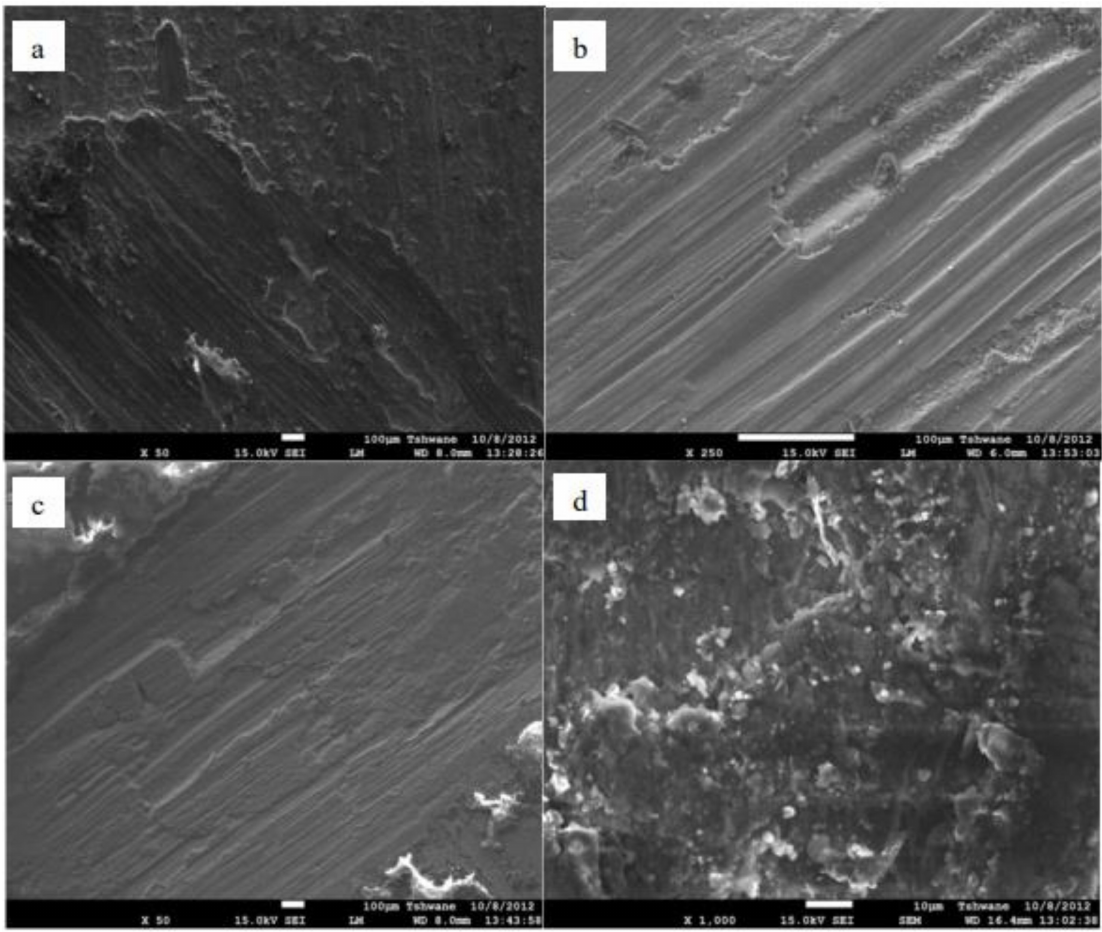
Figure 20. SEM micrograph of worn-out surfaces of ( a ) the single reinforced aluminium–Mg–Si/10 wt% Al 2 O 3 composites, ( b ) hybrid reinforced Al–Mg–Si/2 wt% BLA (bamboo leaf ash)-8 wt% Al 2 O 3 composites, ( c ) hybrid reinforced Al–Mg–Si/ 3 wt% BLA-7 wt% Al 2 O 3 composites, and ( d ) hybrid reinforced Al–Mg–Si/4 wt% BLA–6 wt% Al 2 O 3 composites